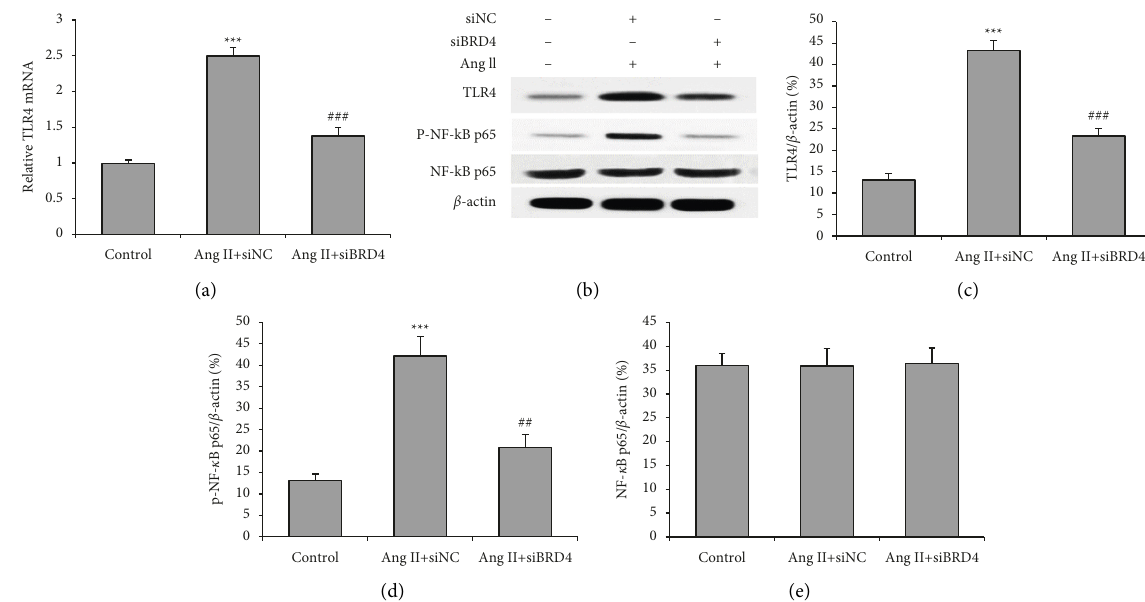
Figure 5: siBRD4 inhibits the TLR4-NF- κ B pathway in Ang II-induced H9c2 cells. Real-time PCR was performed to measure the mRNA level of TLR4 (a). Western blot was carried out to determine the TLR4 (b), phosphorylated NF- κ B p65(c), total NF- κ B p65(d), protein expression in H9c2 cells (e). Each experiment was performed in triplicate and repeated at least three times. ∗∗∗ P < 0 . 001 vs. control group; ## P < 0 . 01, ### P < 0 . 001 vs. Ang II+ siNC